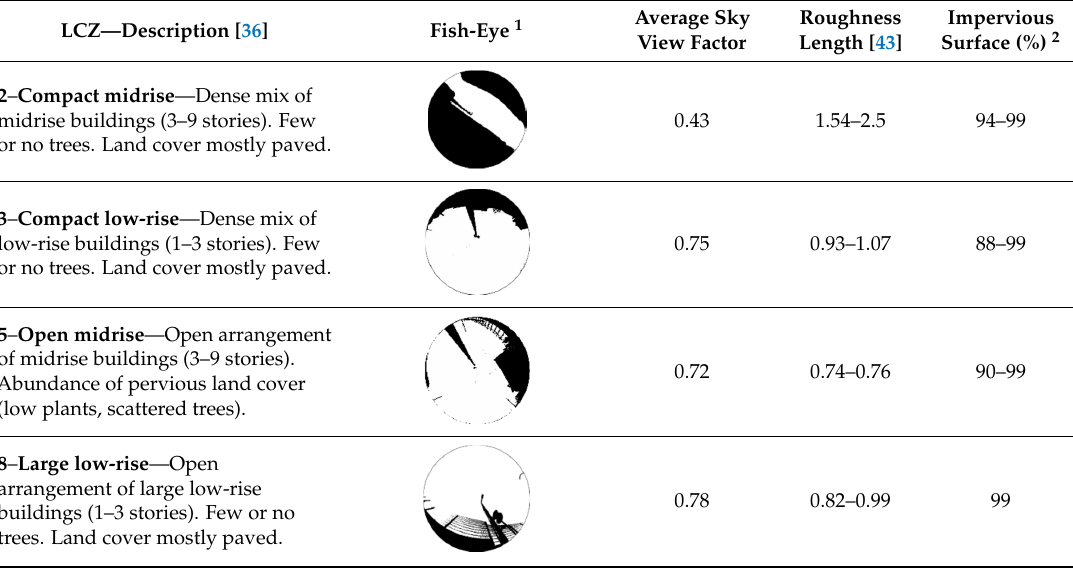
Table 2. Local Climate Zones and their attributes (Based on Stewart and Oke [36]). LCZ—Description [36]